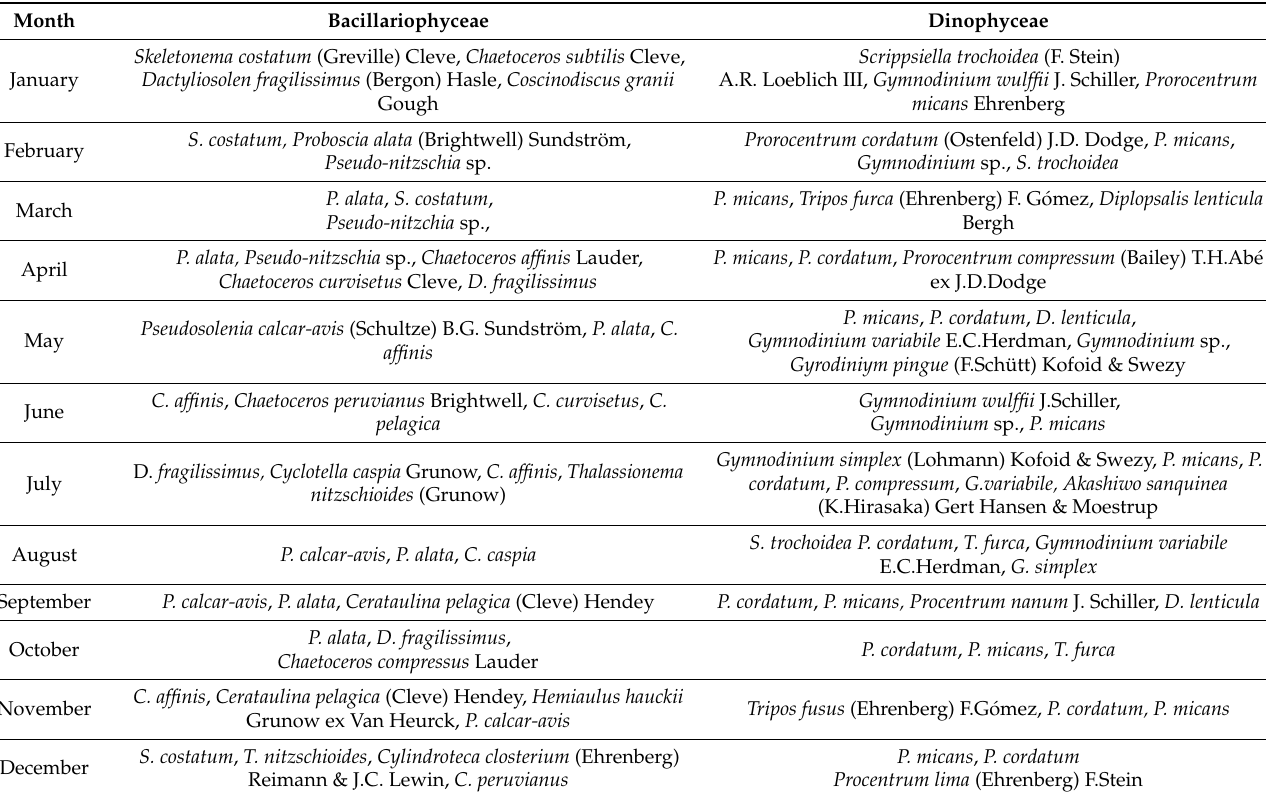
Figure 3. Seasonal dynamics of nutrient concentrations and the permanganate oxidizability (Oxid.): ( A , C )—nitrates (1), ammonium (2), temperature (3); ( B , D )—silicates (1), phosphates (2), Oxid. (3) in Station 1 ( A , B ) and Station 2 ( C , D ). Table 1. Dominant phytoplankton species at Station 1 and Station 2 in